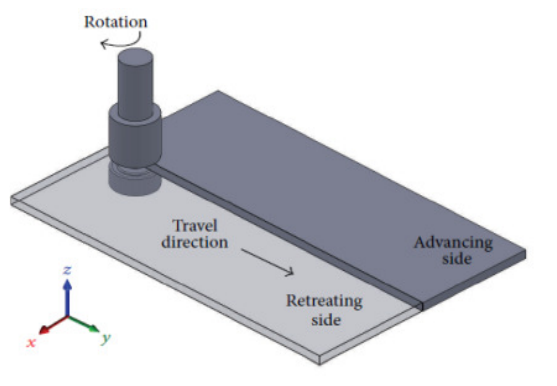
Fig. 1. Schematic diagram of BFSW [4].